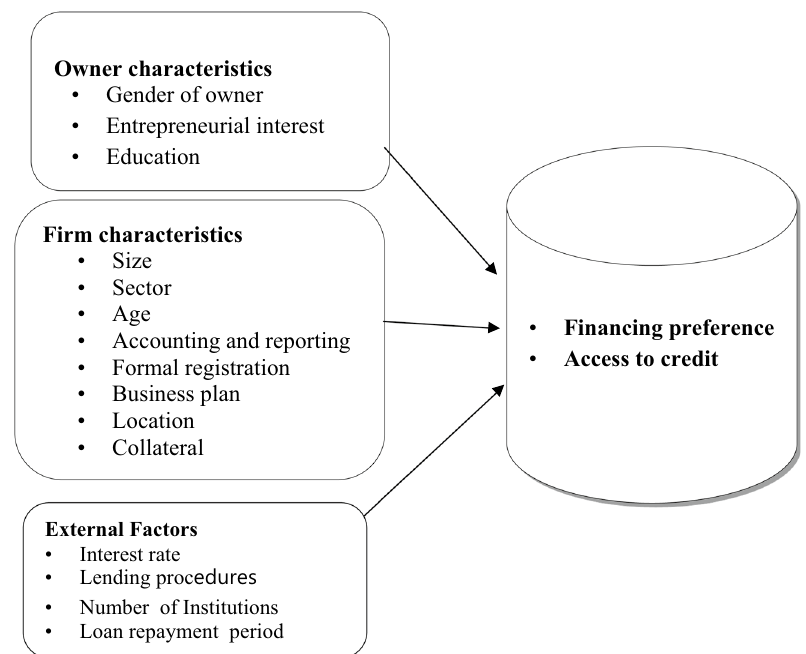
Fig. 1 Conceptual